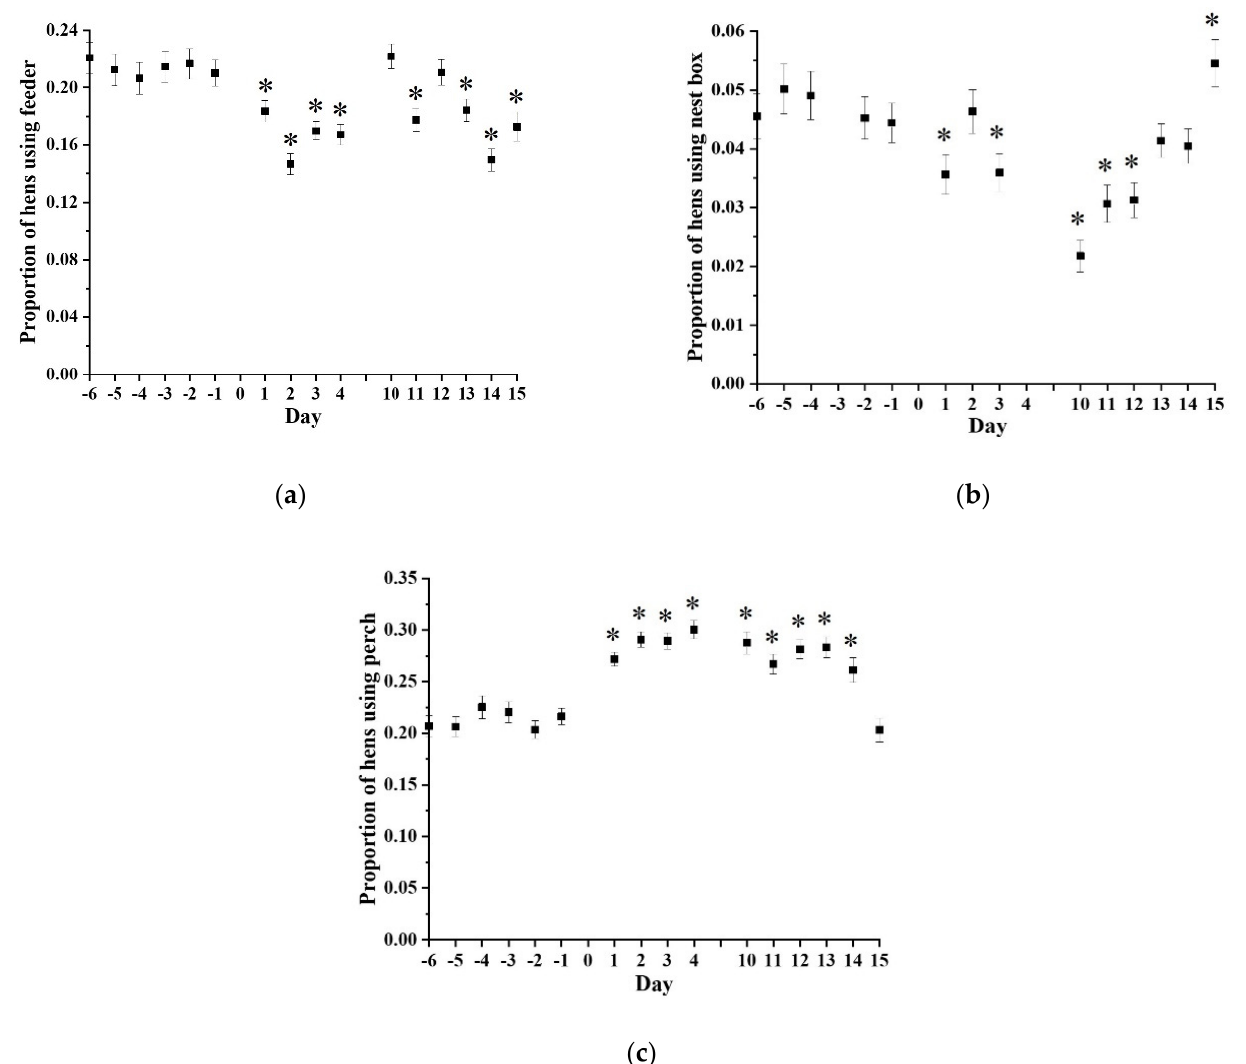
Figure 3. Proportion of laying hens using ( a ) feeder, ( b ) nest box, and ( c ) perch on all observation days. Differences between each observation day after backpack attachment and the mean from − 6 d to − 1 d ( p < 0.05) are indicated with an asterisk.